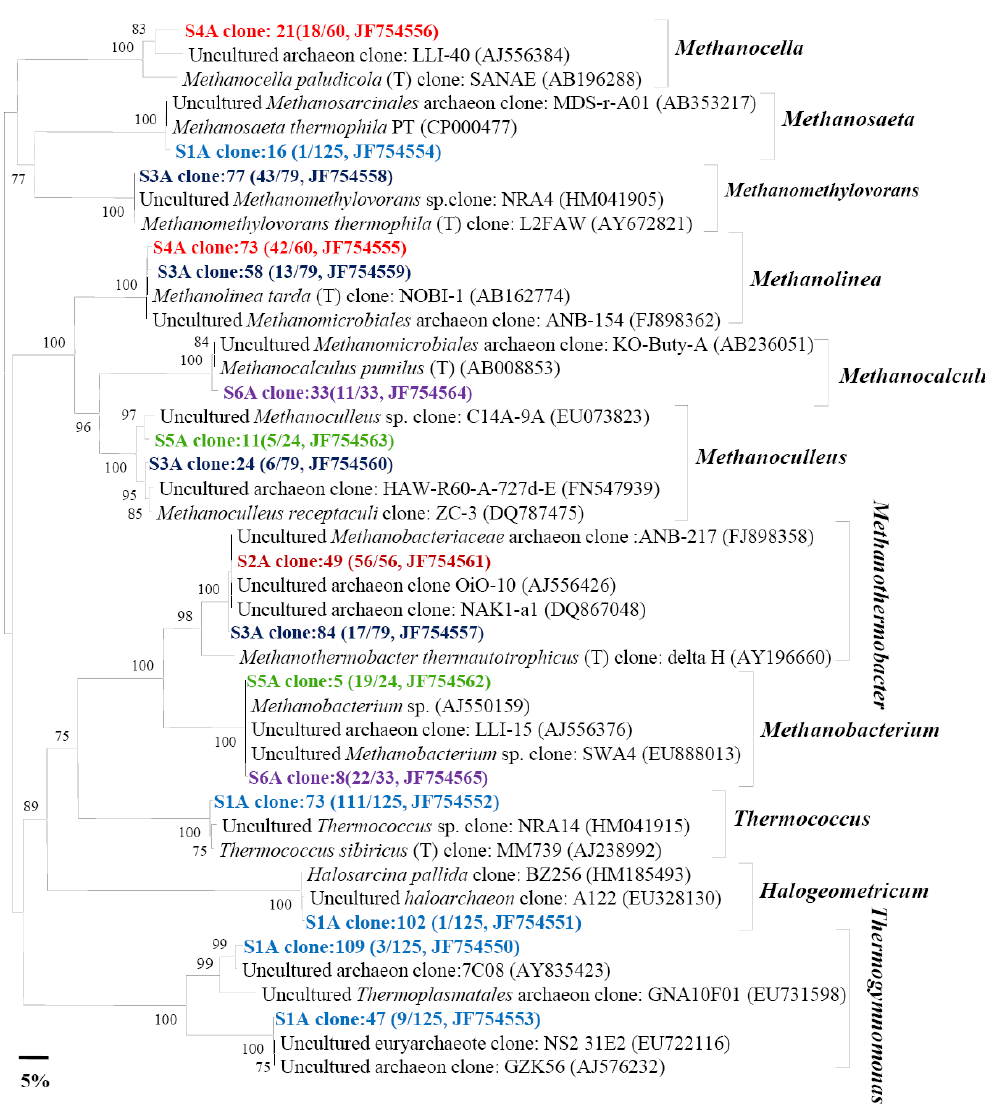
Fig. 4. Phylogenetic tree of the archaeal 16S rRNA gene phylotypes retrieved from six different petroleum reservoirs (shown in bold) and closely related sequences from GenBank database. Alignments to related sequences (shown with accession number) were performed with MEGA 4 software. The topology of the tree was obtained with the neighbor-joining method. Bootstrap values ( n = 1000 replicates) of ≥ 75% are reported. Scale bar represents nucleotide changes per site. Sampling locations are as named in Table 1.